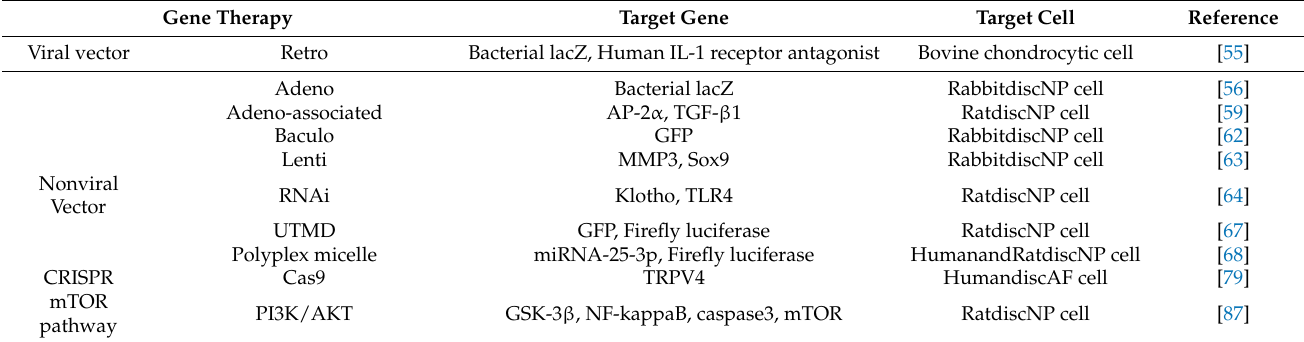
Table 1. Recent studies of gene therapy associated with intervertebral disc